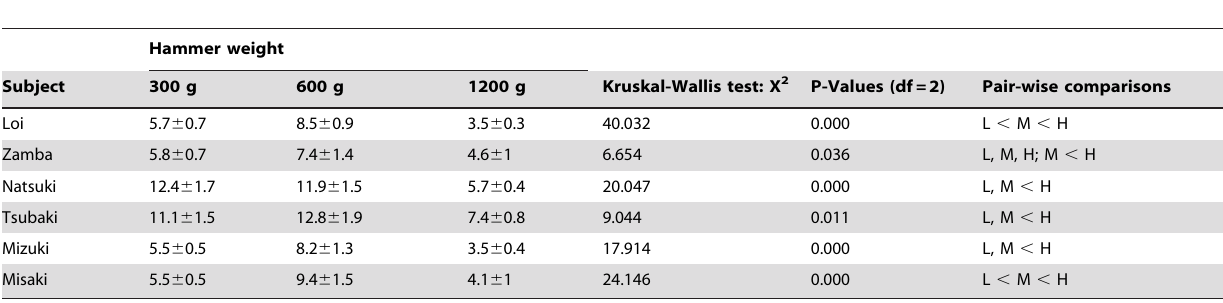
Table 1. Average number of strikes ( 6 SE) needed to solution for all subjects as a function of hammer weight in Experiment 1.